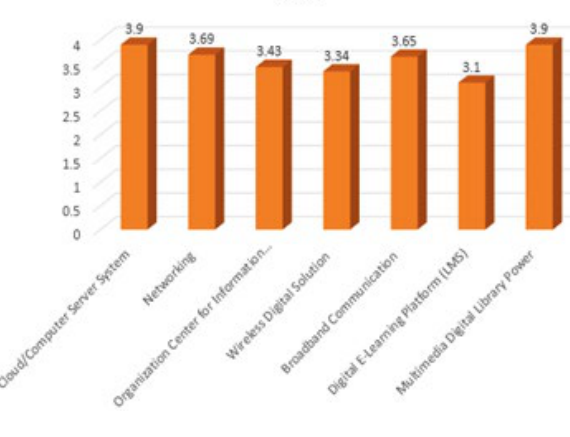
Figure 4. Institution ICT